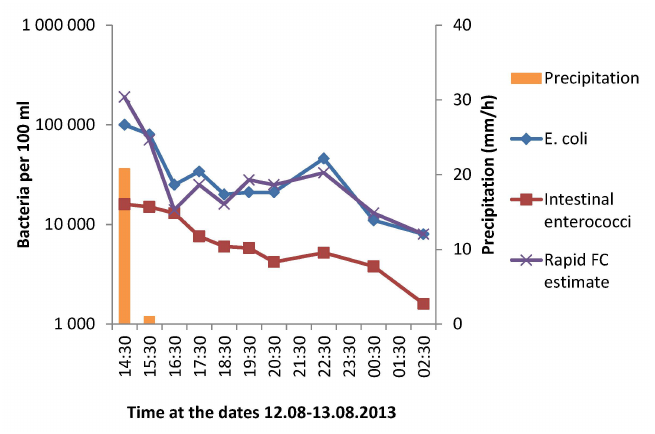
Figure 2. Fecal indicator bacteria in the Hovinbekken River during and after heavy rainfall on 12 August 2013.